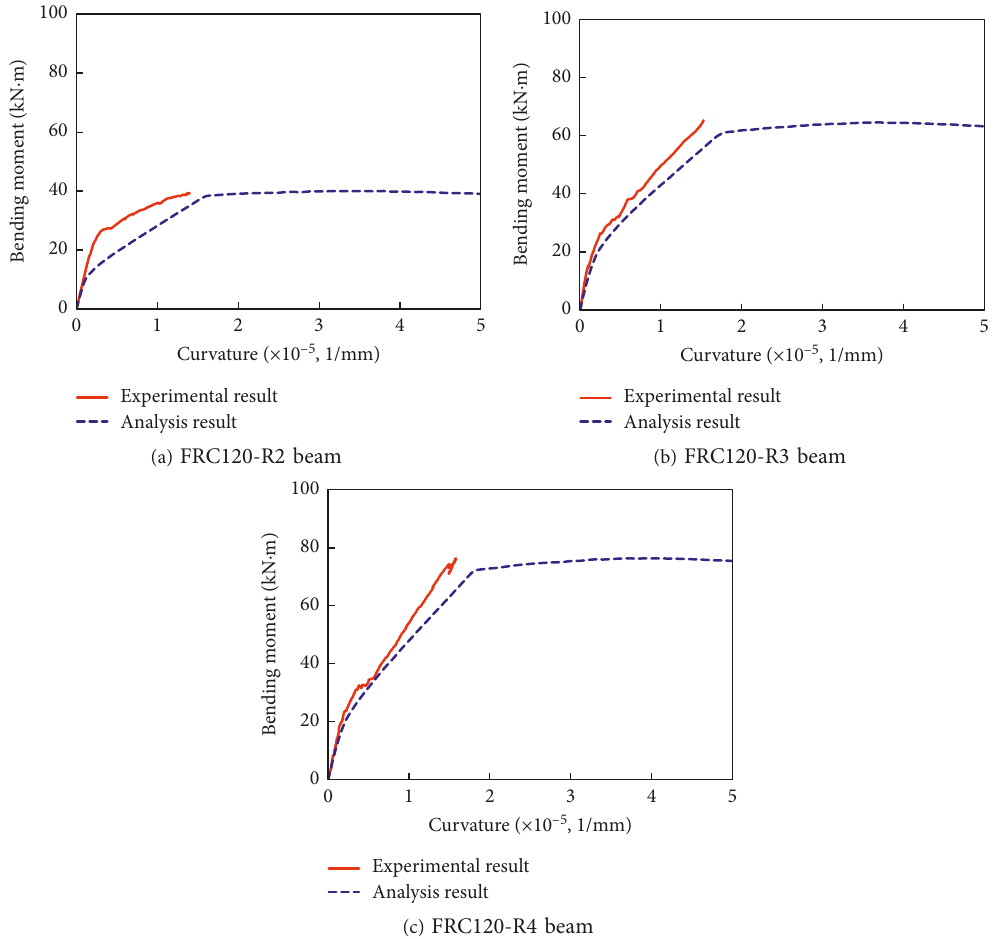
Figure 15: Fitting of moment-curvature curves between the experimental and analysis results (FRC120 series